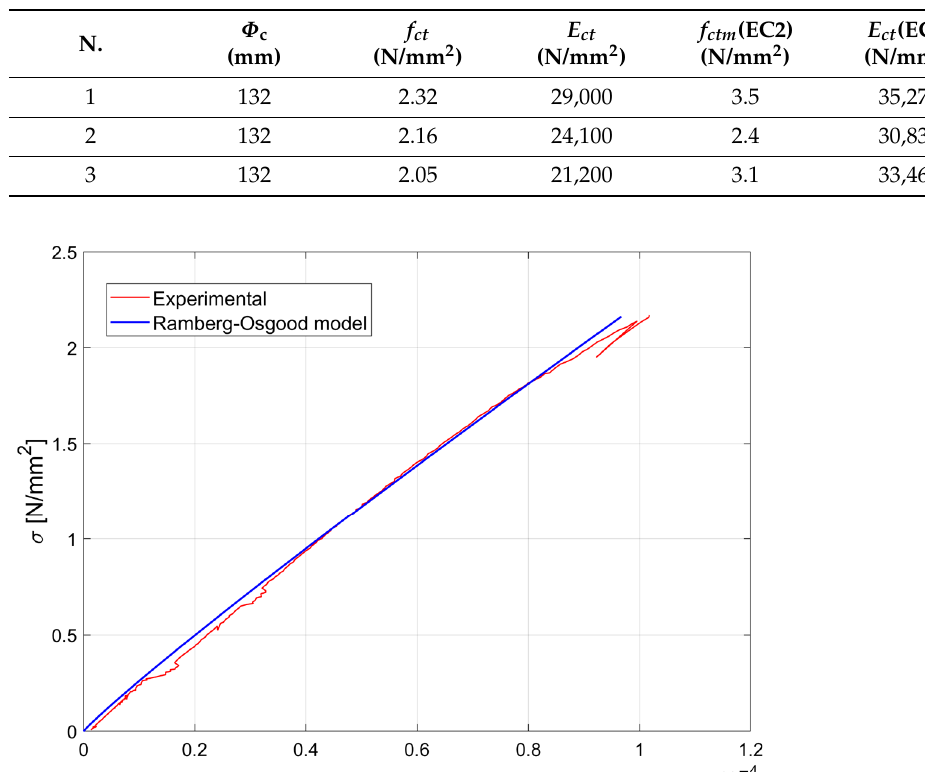
Table 4. Results of direct uniaxial tensile tests on concrete specimens.